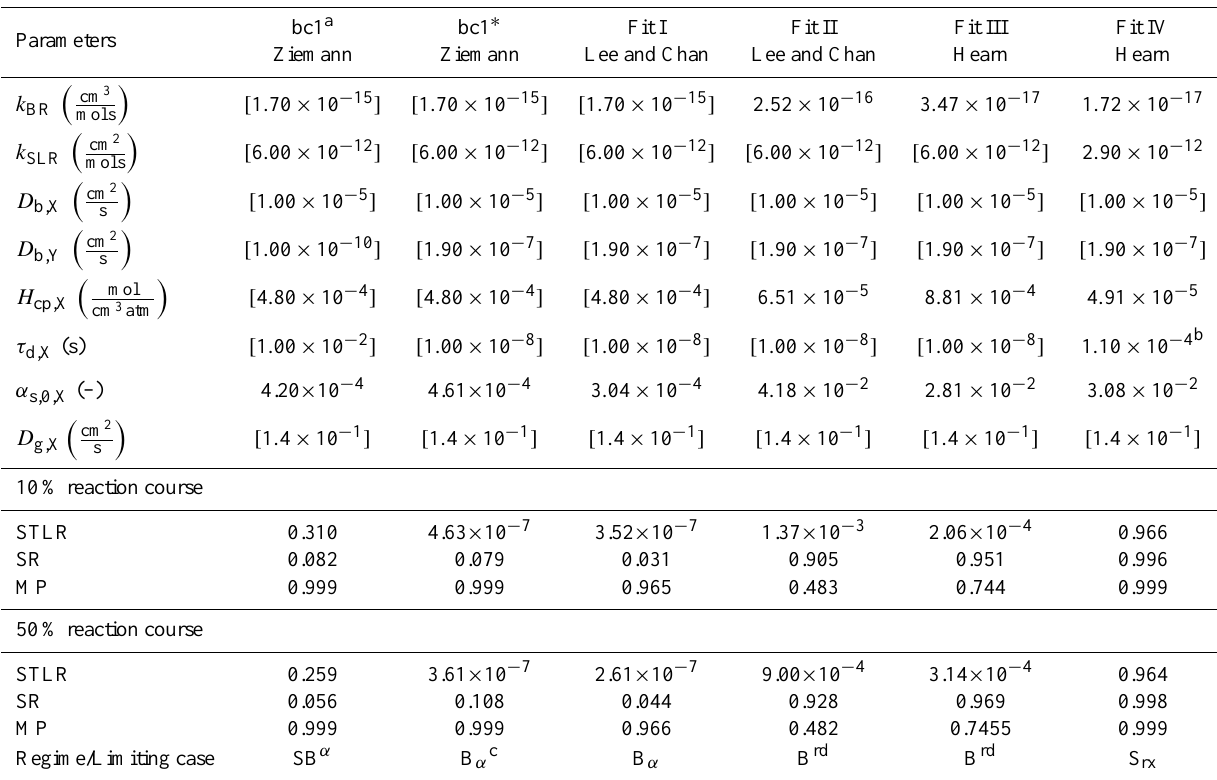
Table 6. Kinetic parameter sets for KM-SUB that represent possible fits to experimental data provided by Ziemann (2005), Lee and Chan (2007) and Hearn et al. (2005). bc1, bc1 ∗ and Fit I are obtained by adjusting α s,0,X while Fits II to IV are multi-parameter fits, obtained by least-squares fitting of modelled to experimental data. Even though Fits II and III do not exhibit limiting case behaviour, they can still be assigned as a bulk reaction limited by reaction and diffusion (reacto-diffusion limitation). Values that were fixed during the fitting procedures are marked with square